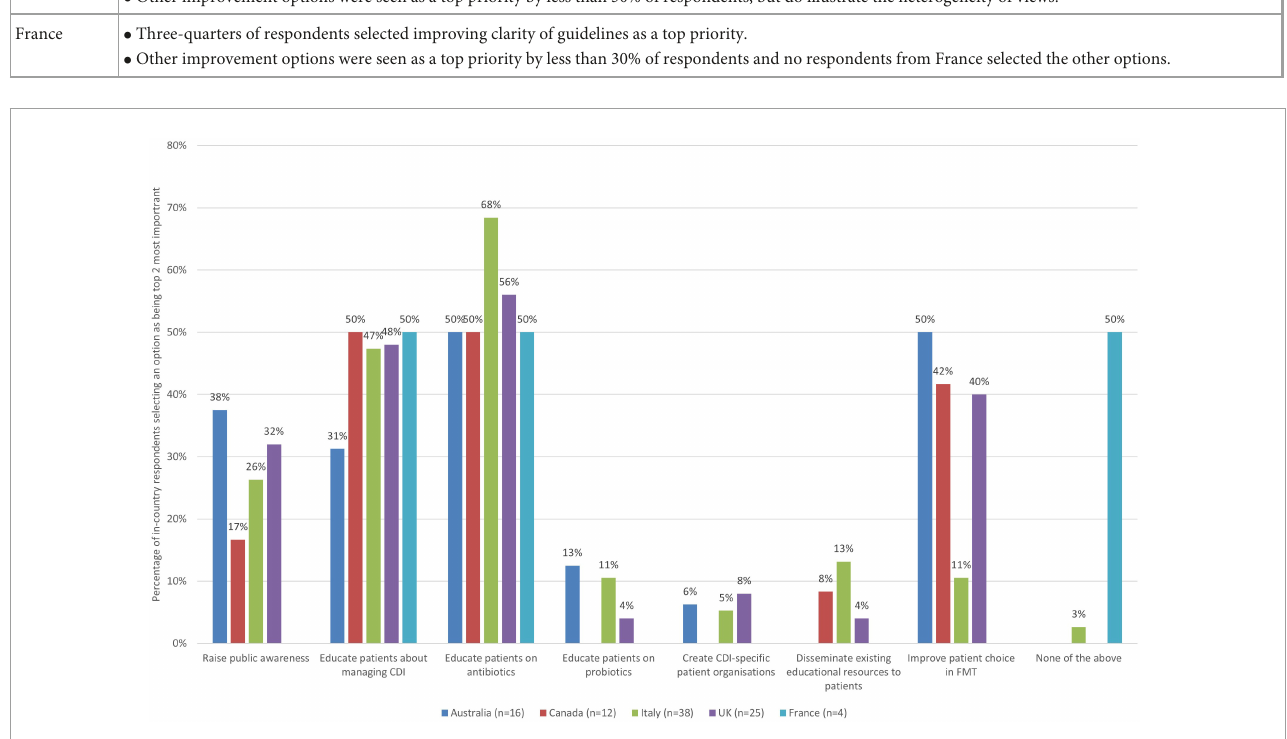
FIGURE4 The 2 improvement actions related to education and awareness raising for patients that are the most important (bars represent the percentage of respondents that rated each improvement action as one of the most important by country).